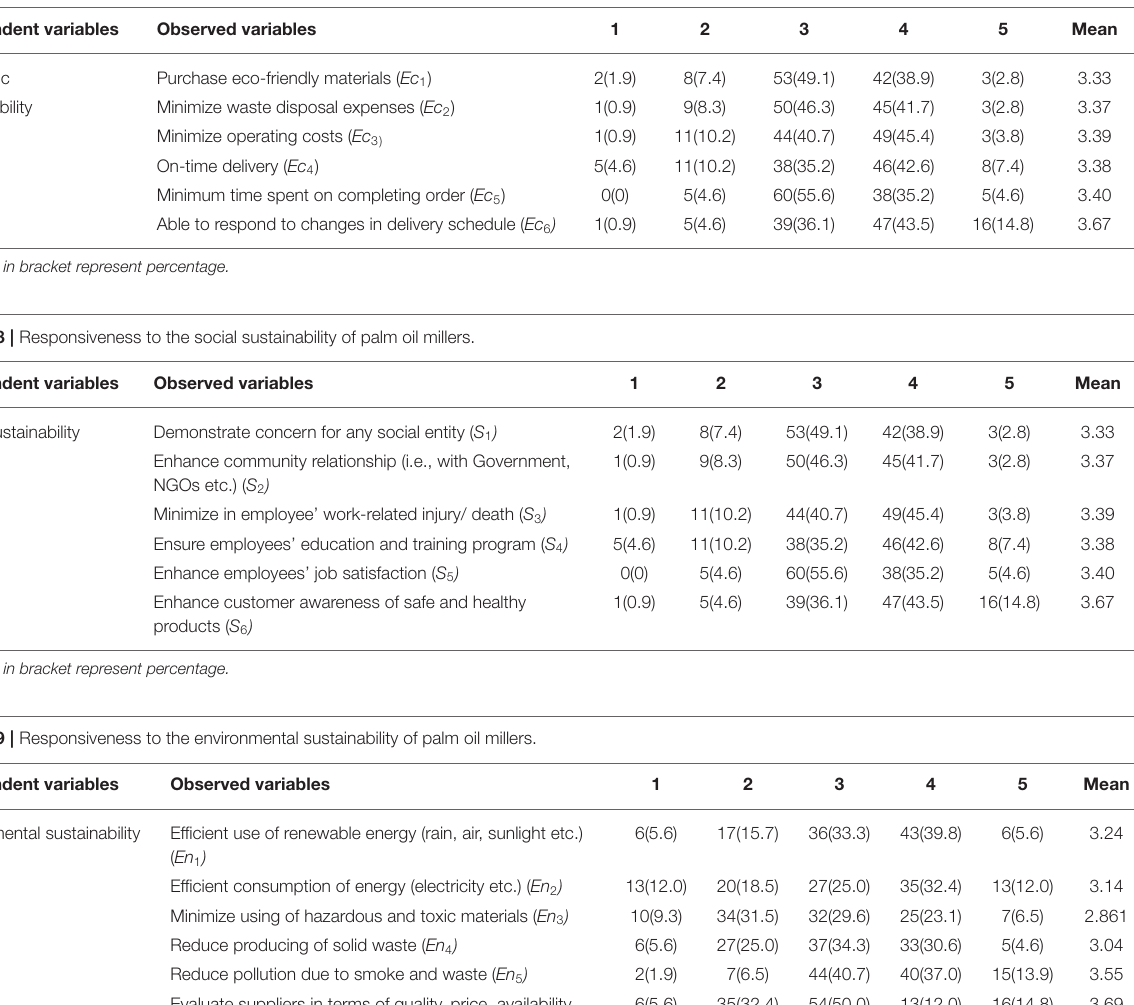
TABLE 7 | Responsiveness to the economic sustainability of palm oil millers. Independent variables